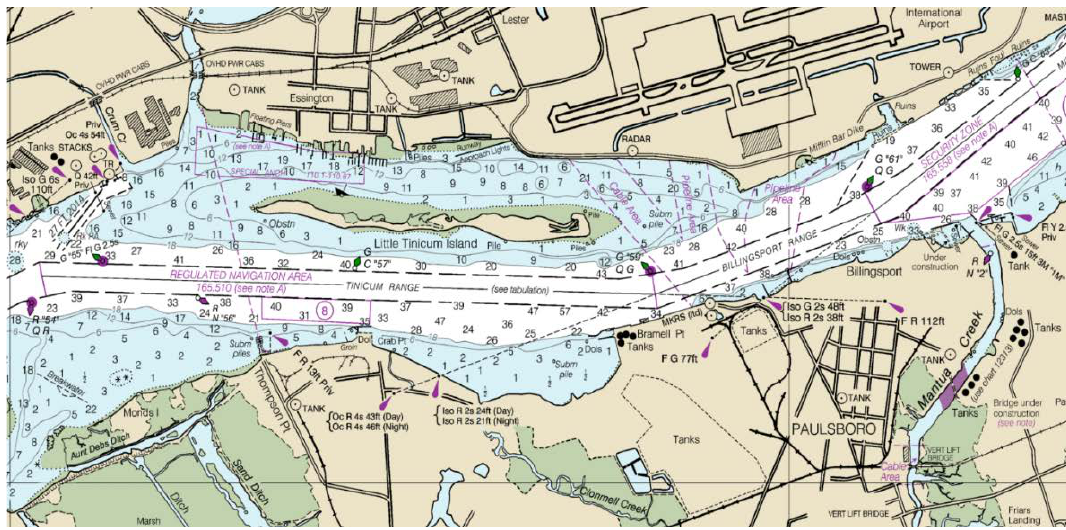
Figure 4. Bathymetric chart in the Delaware River (NOAA Chart 12312). (Cardinal directions in image: North = top, South = bottom, East = right, West = left).